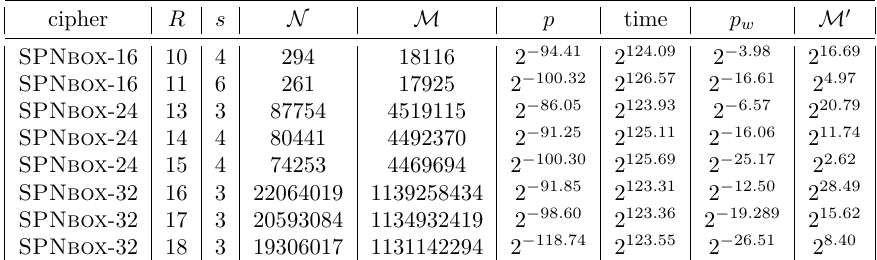
Table 6: Summary of filter-then-guess technique on SPNbox